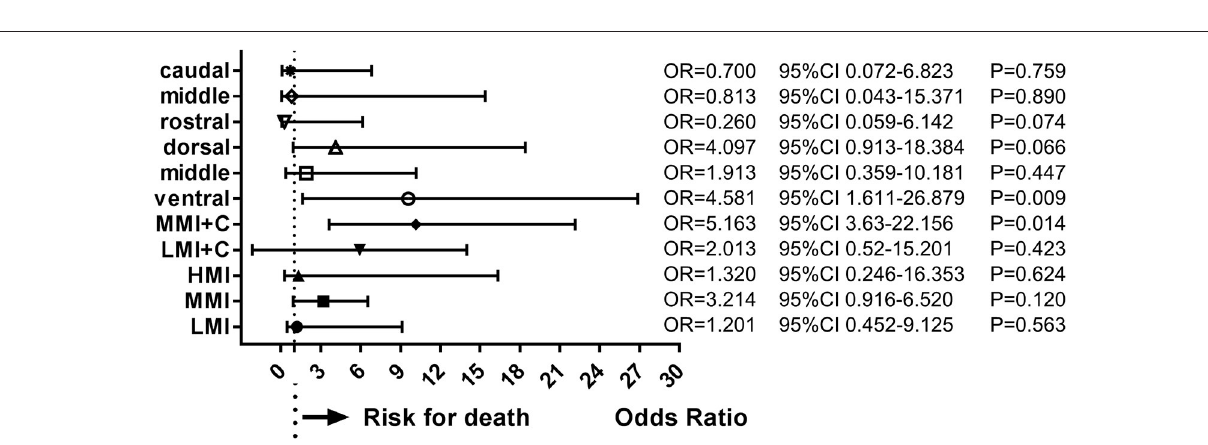
FIGURE 6 | Risk factors of infarct sites for death. Ventral MI and MMI + C were risk factors for death. LMI, lateral medullary infarction; MMI, medial medullary infarction; LMI + C, LMI + cerebellar infarction; MMI + C, MMI + cerebellar infarction. patients. In a follow-up study of MMI, 16.2% (11/68) patients favorable outcomes (9). Based on these reports and other small series, MI has been regarded as a benign condition. However, died (3). A systematic review of 38 BMMI patients revealed poor the outcome is not uniformly favorable, especially for MMI clinical outcomes with a 23.8% in-hospital mortality (20).